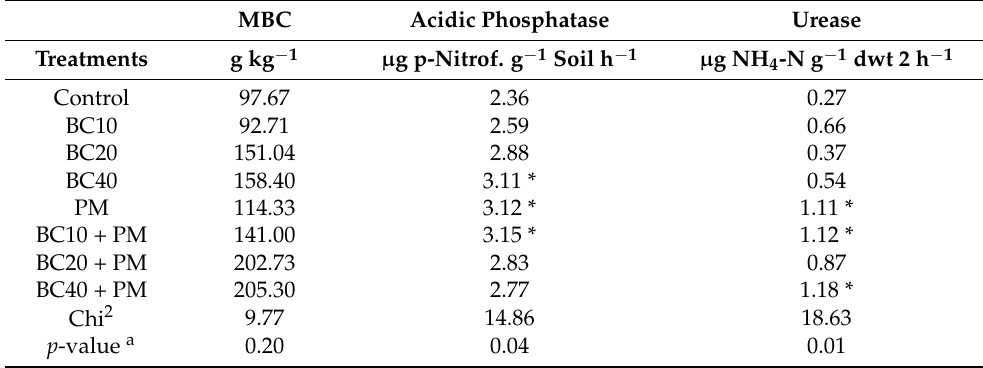
Table 5. Effects of biochar (BC), applied at 10, 20 or 40 t ha − 1 , and poultry manure (PM, 5 t ha − 1 ) on soil biological properties.